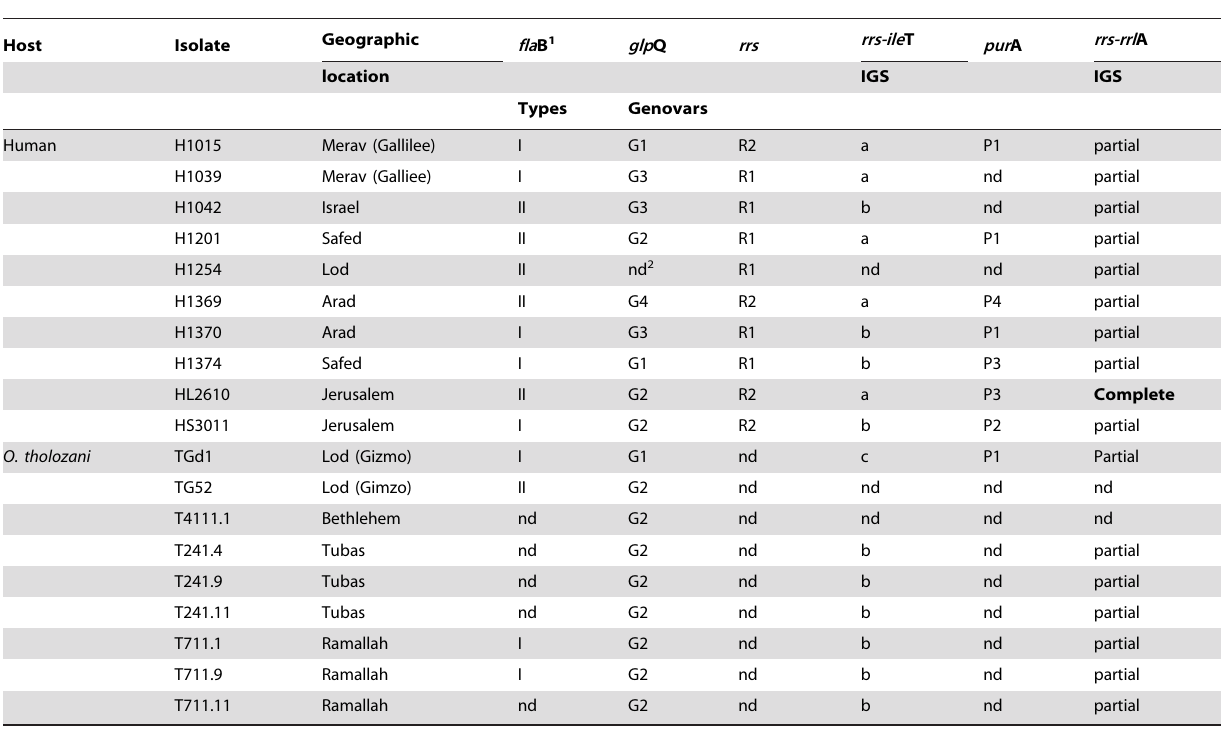
Table 1. Characterization of the isolates investigated in this